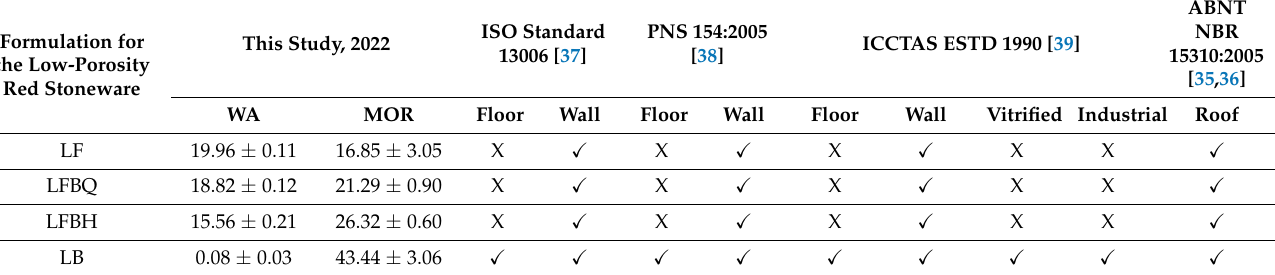
Table 5. Quality compliance